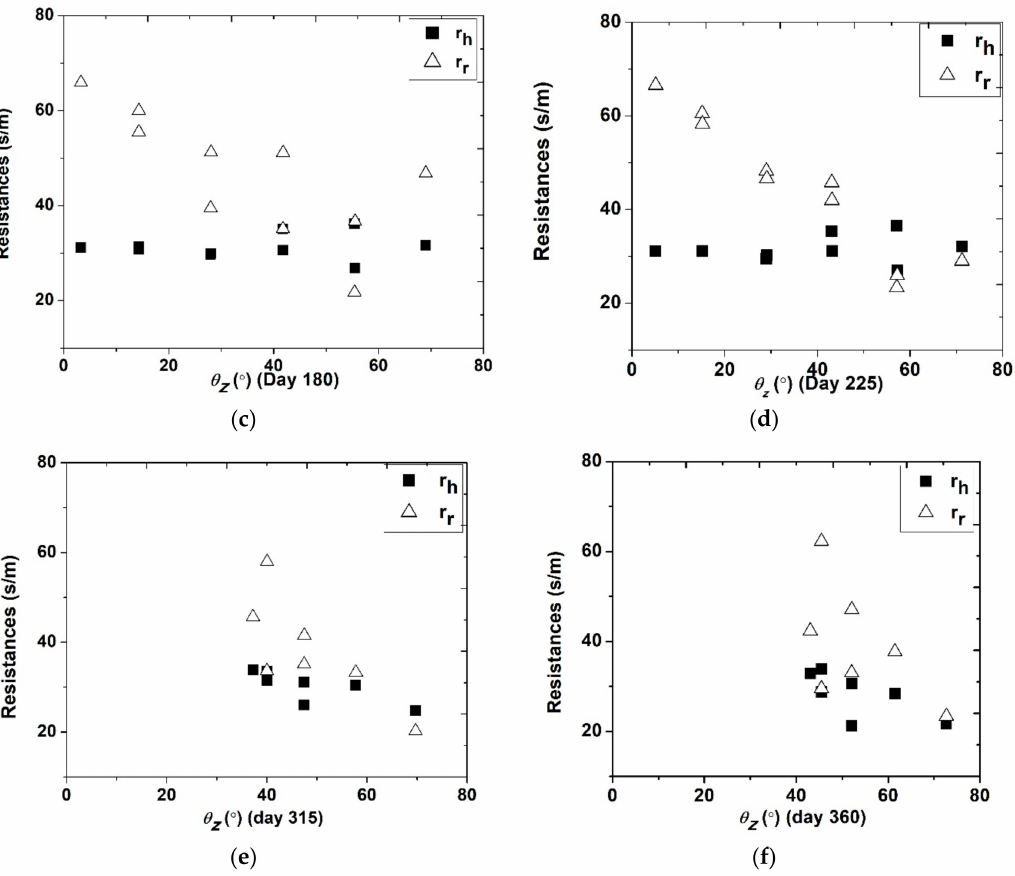
Figure 5. Resistances versus θ z on di ff erent days of the year (DoYs): ( a ) 45; ( b ) 90; ( c ) 180; ( d ) 225; ( e ) 270; and ( f )